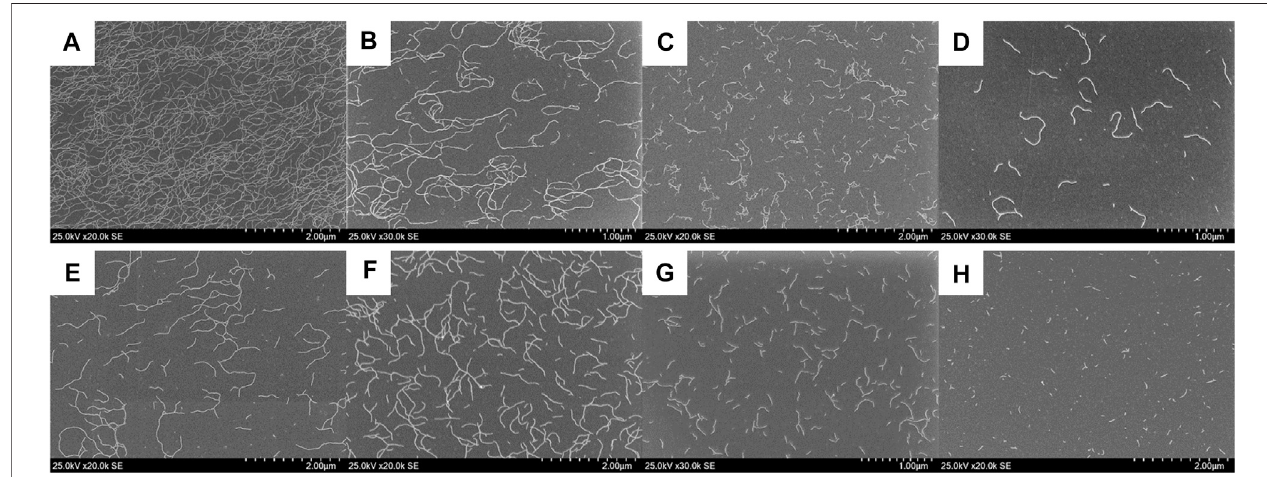
FIGURE 4 | SEM images of ( S )-Binaph-PDI-Biph-PDI coassemblies with the ( S )-Biph-PDI content of (A) 90, (B) 80, (C) 70, (D) 60, (E) 50, (F) 40, (G) 30, and (H) 20 mol%.